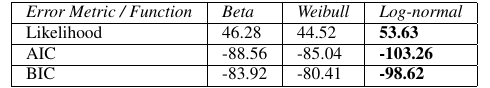
Table 1. PDF fitting error for Sentinel-1